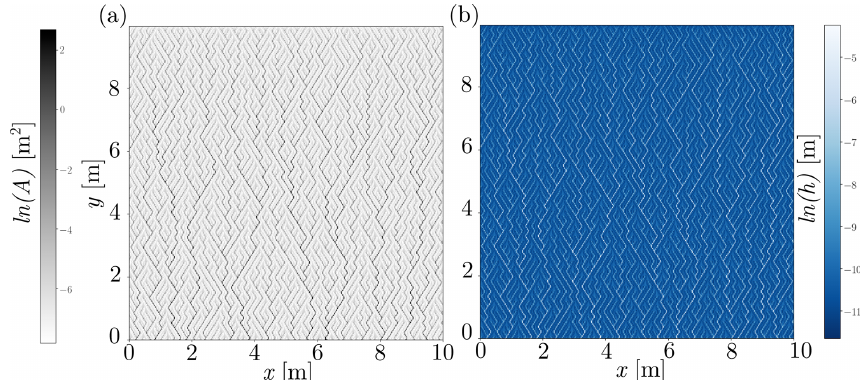
Figure 12. (a) Map of contributing area of half of an idealized hillslope. Color scale is in log scale to make small rills visible and highlight the entire network. (b) Map of steady-state flow depths according to our numerical model for runoff values of 5cmh − 1 . This illustrates the results of numerical flow routing. From this result, we calculate exceedance probabilities that compare to theoretical distributions. Color scale is in log scale.